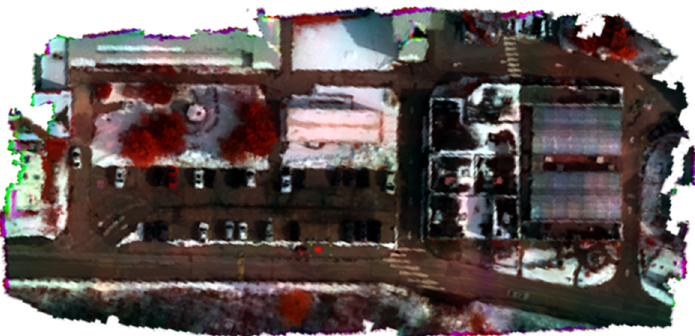
Figure 8. False-color combination of the multispectral orthomosaic for the first test site.